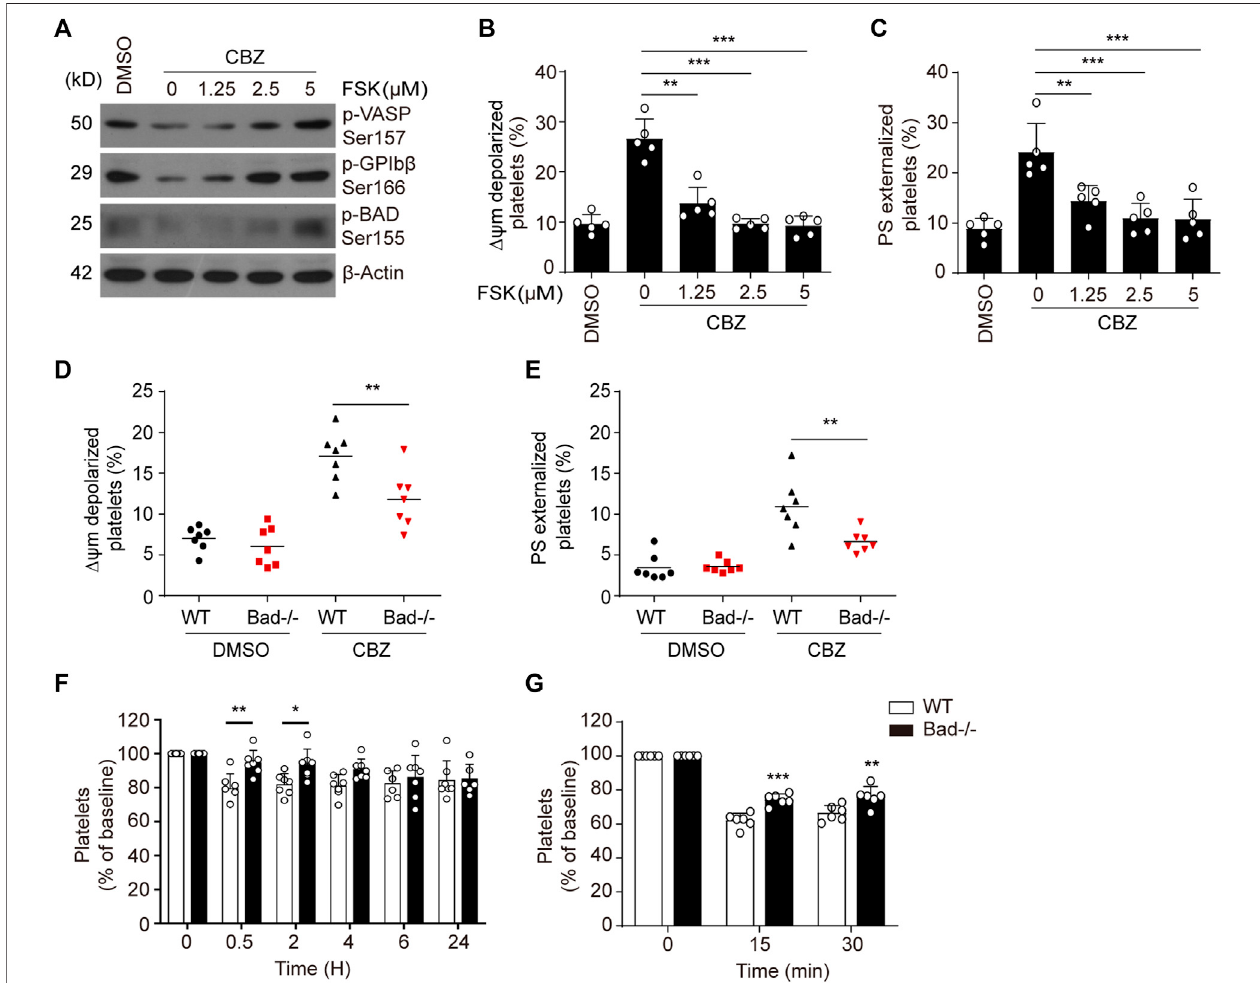
FIGURE3| ActivationofPKArescuesplateletsfromapoptosisinducedbyCBZ. (A – C) Washedhumanplateletswerepre-treatedwithindicatedconcentrationsof PKA activator forskolin or vehicle control at 37 ° C for 5 min followed by 100 μ M CBZ incubation at 37 ° C for 70 H. (A) Western blot analysis of phosphorylated VASP at Ser157,phosphorylatedGPIb β atSer166,andphosphorylatedBADatSer155inplatelets.(BandC)Platelet △ ψ m depolarization (B) andPSexposure (C) weredetected by fl owcytometry; n (cid:2) 5.Dataareexpressedasmean ± SD.** p < 0.01,*** p < 0.001,comparedwithcontrolwithone-wayANOVA. (D,E) WashedplateletsfromWT or Bad − / − mice were incubated with 100 μ M CBZ at 37 ° C for 6 H. Platelet △ ψ m depolarization (D) and PS exposure (E) were detected by fl ow cytometry; n (cid:2) 7 for each group. Data are expressed as mean ± SD. Horizontal lines are the representatives of median values and each dot indicates one mouse. ** p < 0.01, *** p < 0.001, compared with WT control by Student ’ s t -test. (F) WT and Bad − / − mice were i.v. injected with a single dose of CBZ (1.2 mg/kg). After injection, platelet counts were determined at the indicated time points; n (cid:2) 7 for each group. (G) C57BL/6J mice were i.v. transfused with calcein-labeled CBZ-treated platelets from Bad − / − or WT littermates; n (cid:2) 6 for each group. (F,G) Data are mean ± SD; * p < 0.05, ** p < 0.01, *** p < 0.001 versus control group, two-way ANOVA prior to Bonferroni post hoc